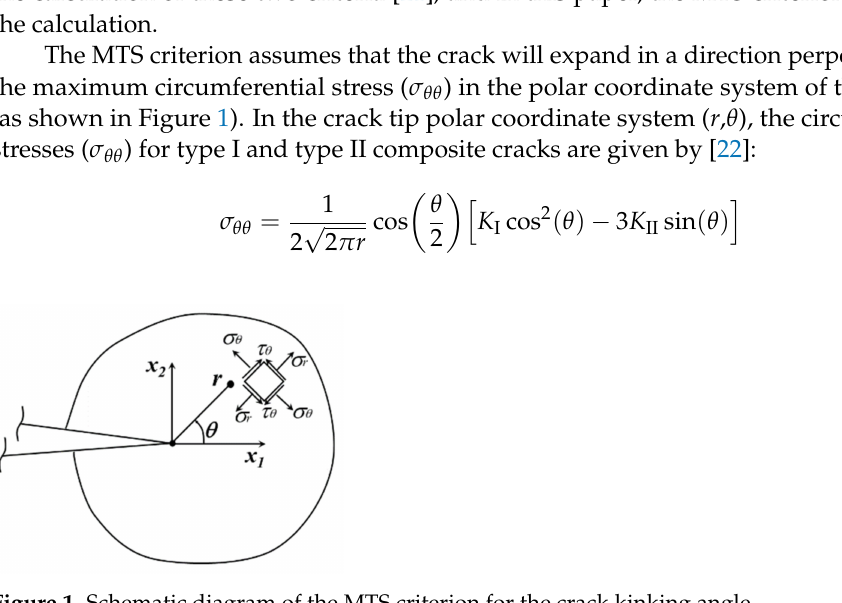
Figure 1. Schematic diagram of the MTS criterion for the crack kinking